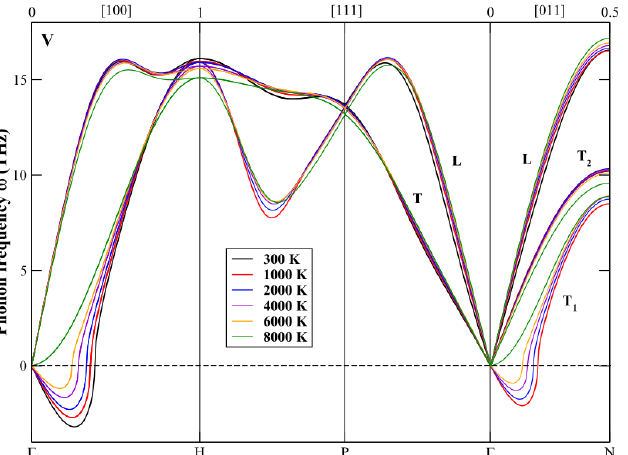
Figure 3. Calculated phonon dispersions for vanadium under different temperatures at a pressure of 182 GPa. (By the courtesy of Ref. [78]).